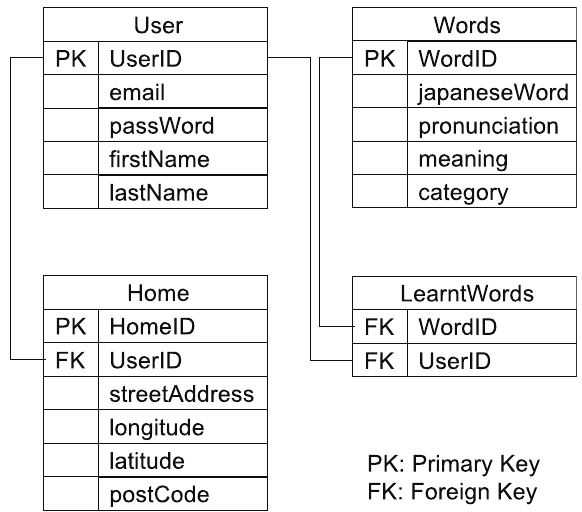
Figure 3. Database design of